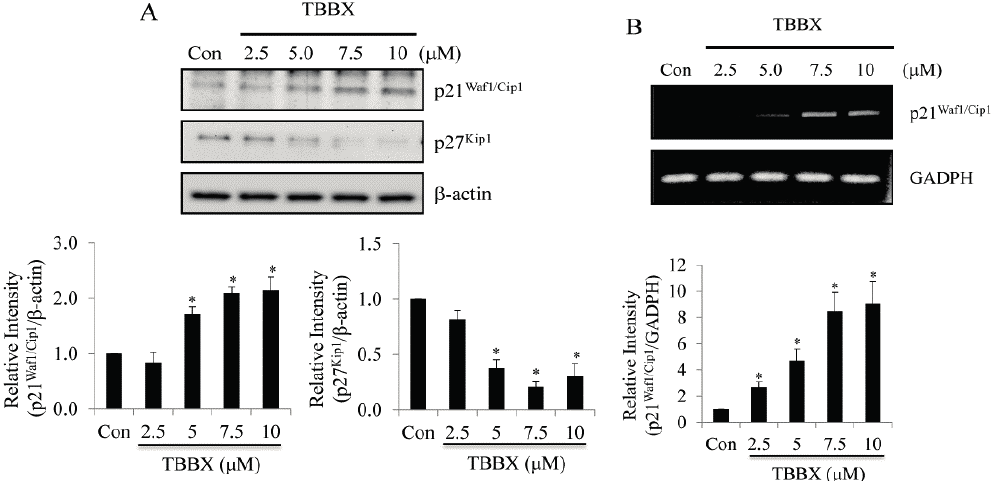
Figure 4. Effects of TBBX on the expression of CDK inhibitors, p21 Waf1/Cip1 and p27 Kip1